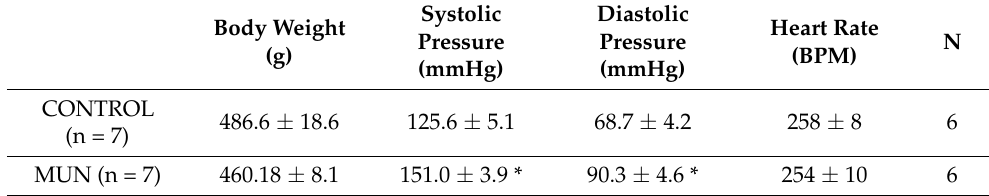
Table 1. Influence of fetal undernutrition on the haemodynamic parameters and body